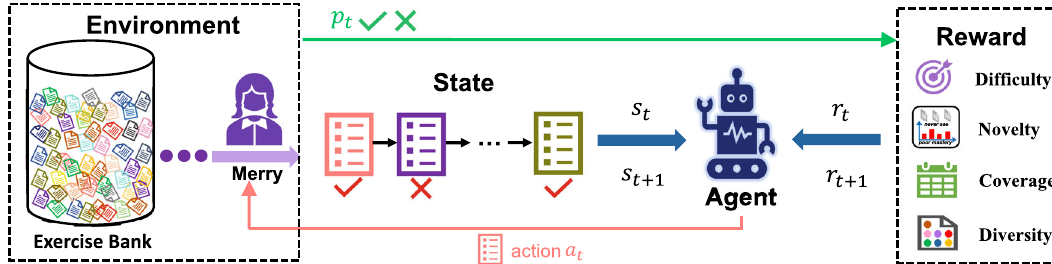
Fig. 2 The architecture of the ER framework